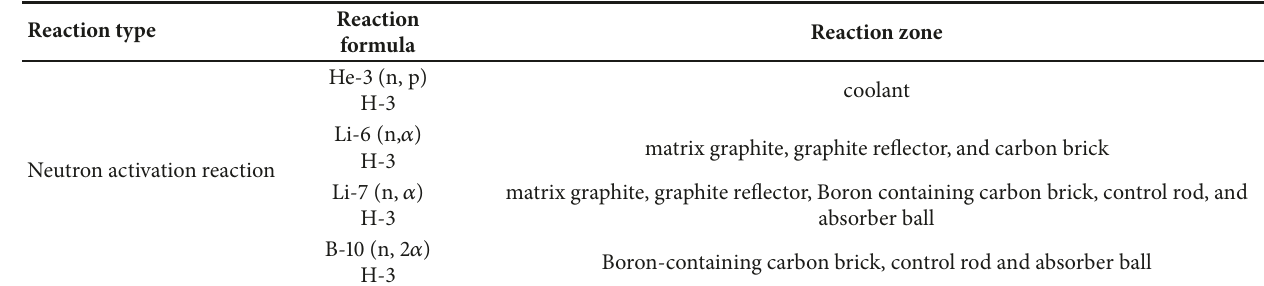
Table 3: Tritium generated in